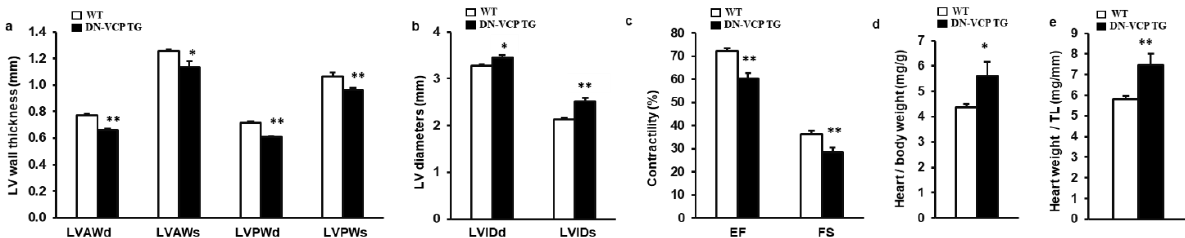
Figure 2. DN-VCP induces a progressive dilated cardiomyopathy and declined cardiac function in the older mice. ( a – c ). Cardiac morphology and function in both VCP dominant-negative transgenic (DN-VCP TG) and wild-type (WT) mice at the age of 52 weeks by echocardiography, representing a decreased LV wall thickness, increased LV diameter and declined contractility in DN-VCP TG mice vs. WT. n = 8/group ; ( d , e ). The heart weights normalized to body weight ( d ) and tibia length (TL) ( e ) in DN-VCP TG vs. WT mice. n = 4 – 6/group. *, p < 0.05 **, p < 0.01 vs age-matched WT mice. LVAWd and LVAWs: LV anterior wall thickness at end-diastole and end-systole; LVPWd and LVPWs: LV posterior wall thickness at end-diastole and end-systole; LVEDd and LVEDs: LV internal dimensions at end-diastole and end-systole; EF and FS: LV ejection fraction and fractional shortening.